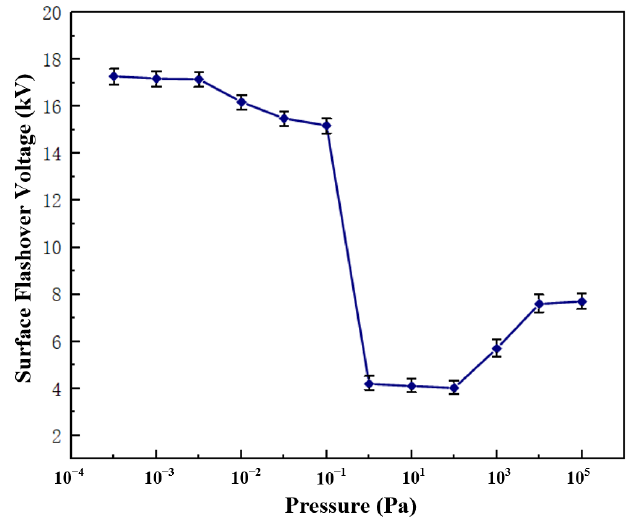
Figure 7. Surface flashover voltage of film under different air pressures.